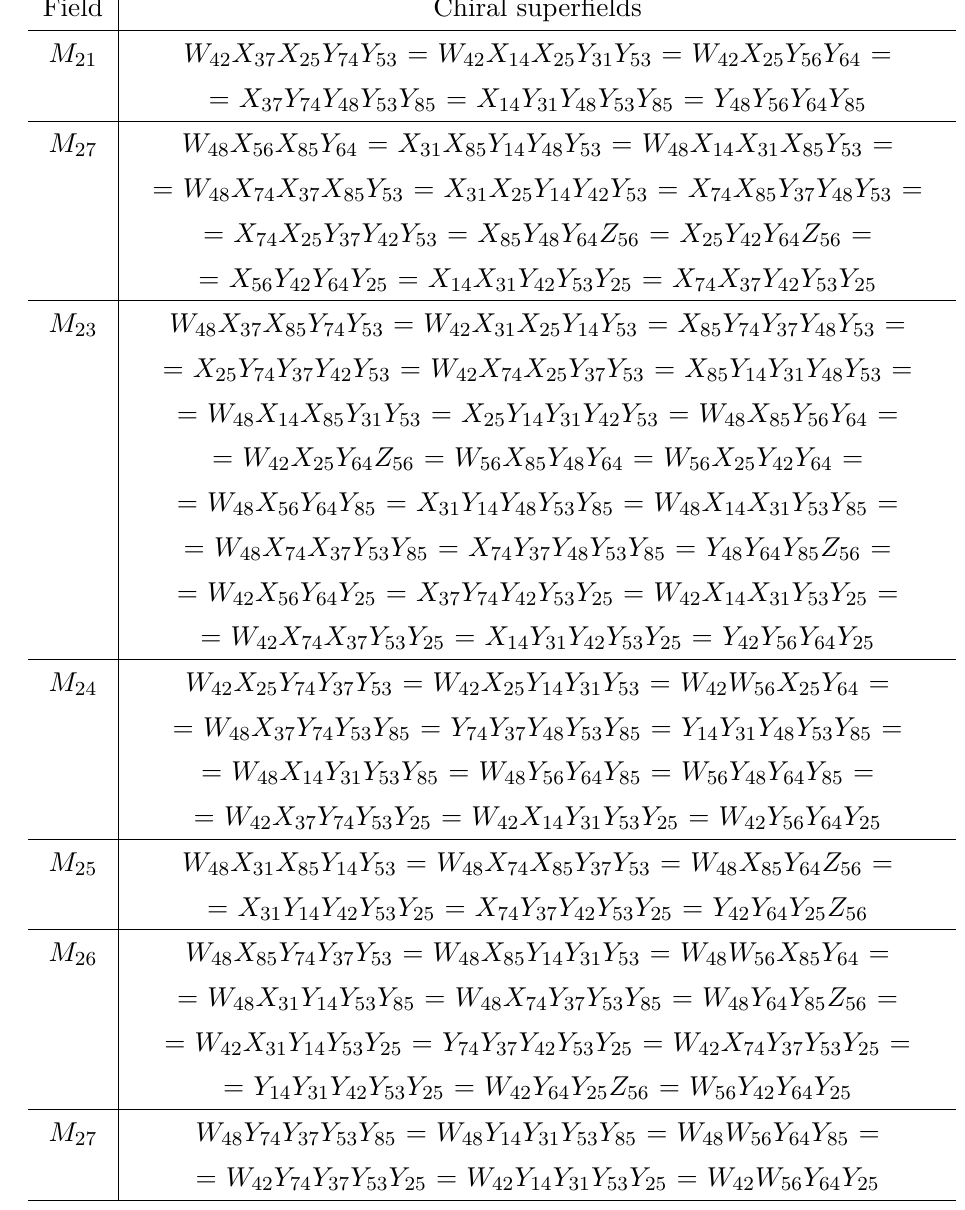
Table 9. Generators of Q 1 , 1 , 1 / Z 2 in Phase